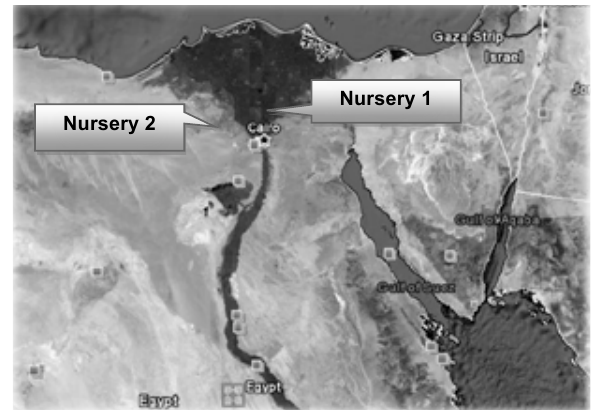
Figure 1. Map of Egypt showing the investigated nursery